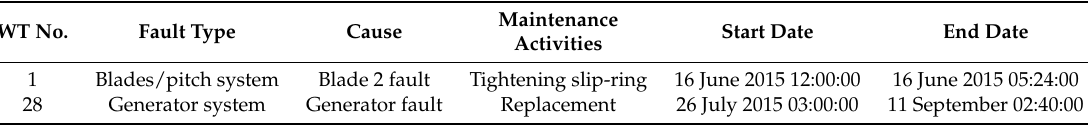
Table 3. Example of status data collected by supervisory control and data acquisition (SCADA) systems. WT